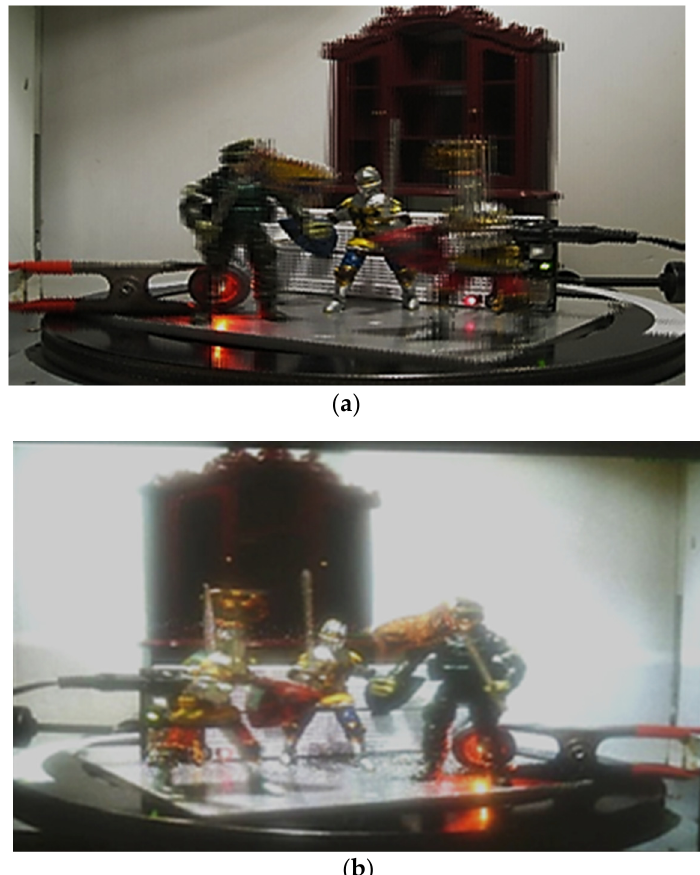
Figure 5. ( a ) Example of 3D image file created in MatLab; ( b ) 3D image with lens array.